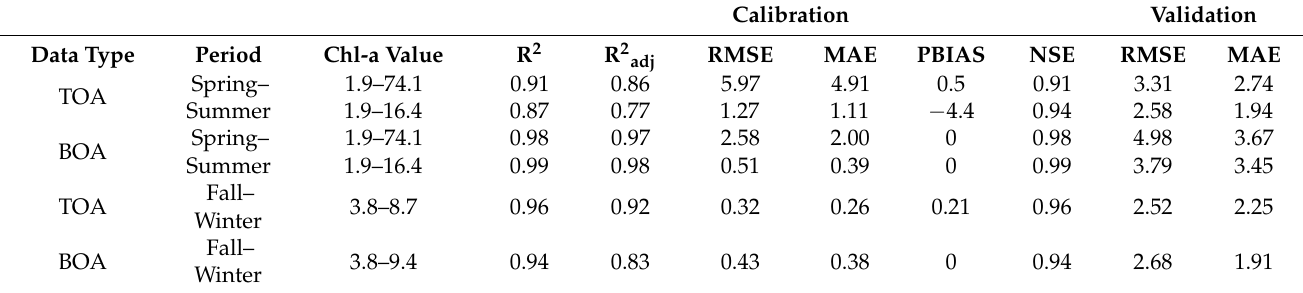
Table 5. Summary of the performance indicators of the MLR for calibration and validation in